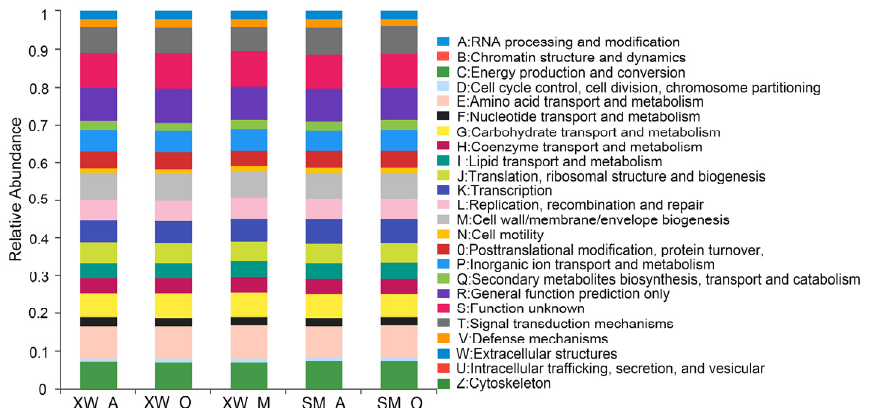
Figure 6. The functional gene prediction of the sludge samples, annotated by the COG